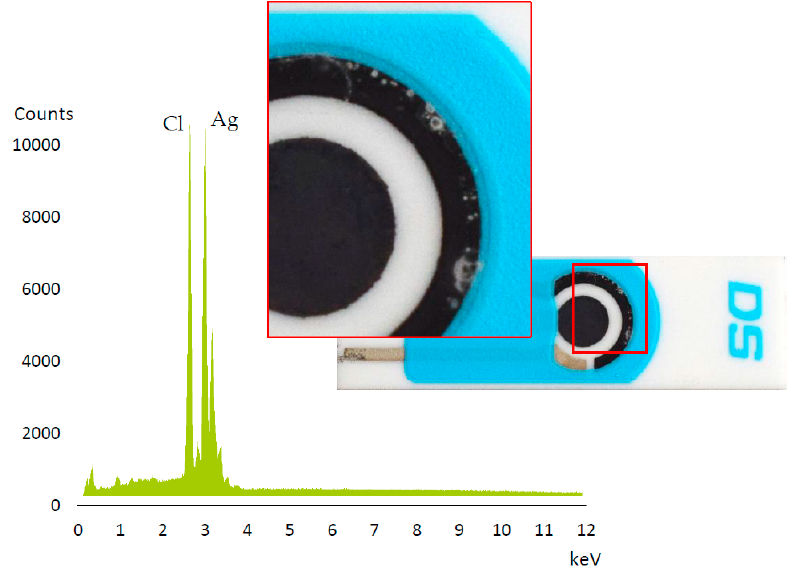
Figure 4. Commercial Bi SP SPE after 25 voltammetric runs (SWASV as indicated in Section 2.5) and EDX results.